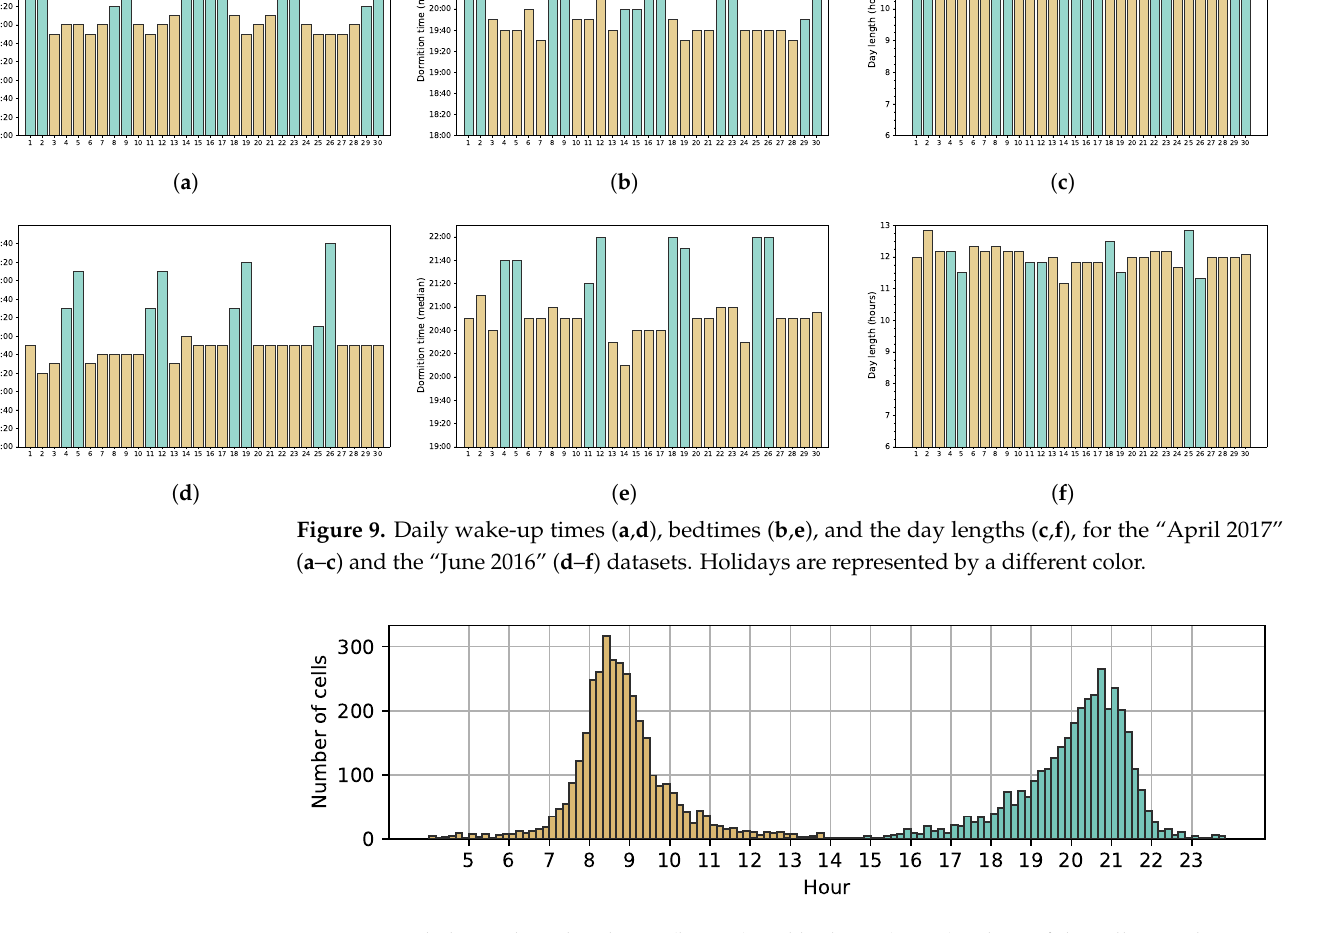
Figure 10. Inhabitant-based wake-up (brown) and bedtime (green) values of the cells, April